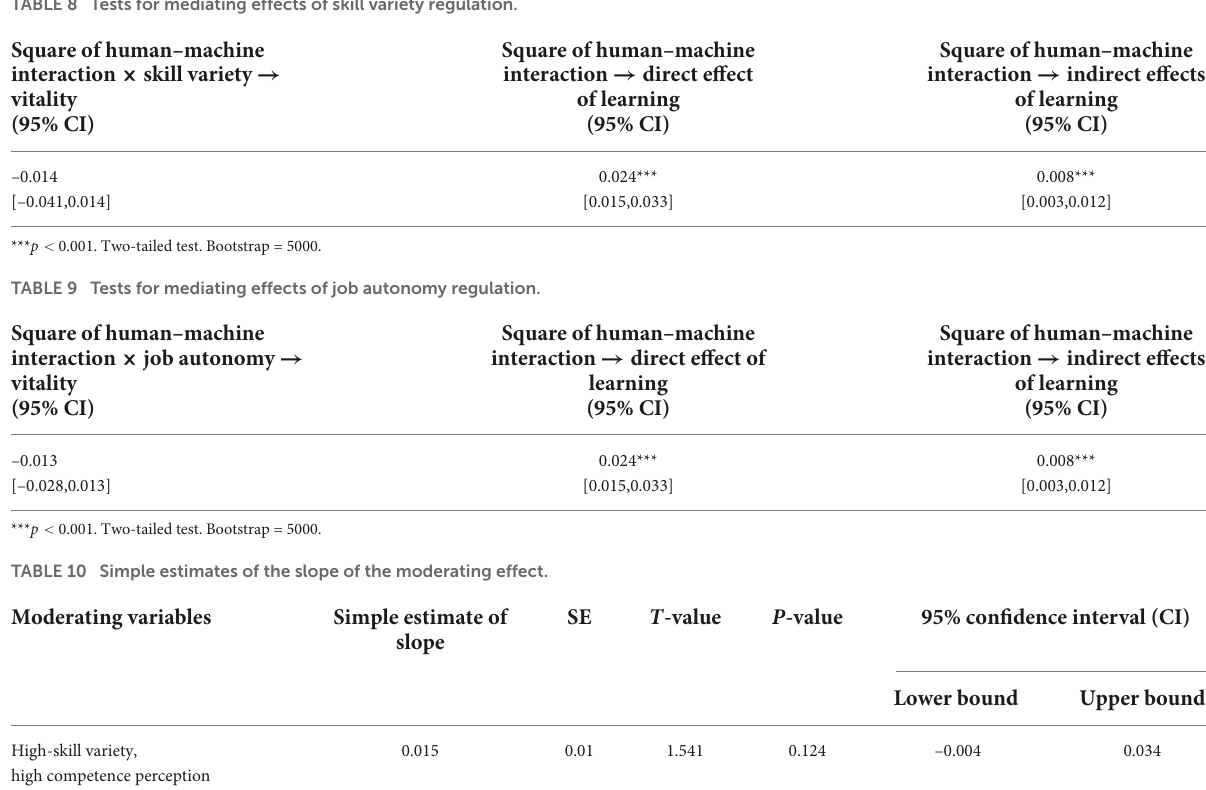
TABLE 8 Tests for mediating effects of skill variety regulation.